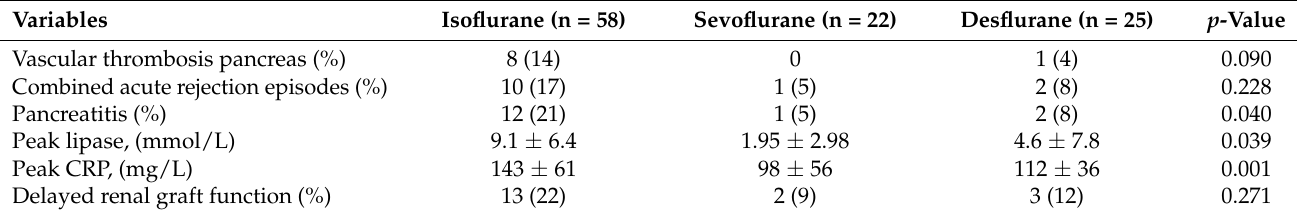
Table 3. Ischemia–reperfusion injury-associated post-transplant clinical outcome parameters follow- ing simultaneous pancreas–kidney transplantation stratified by the primary inhaled anesthetic agent (isoflurane, sevoflurane, and